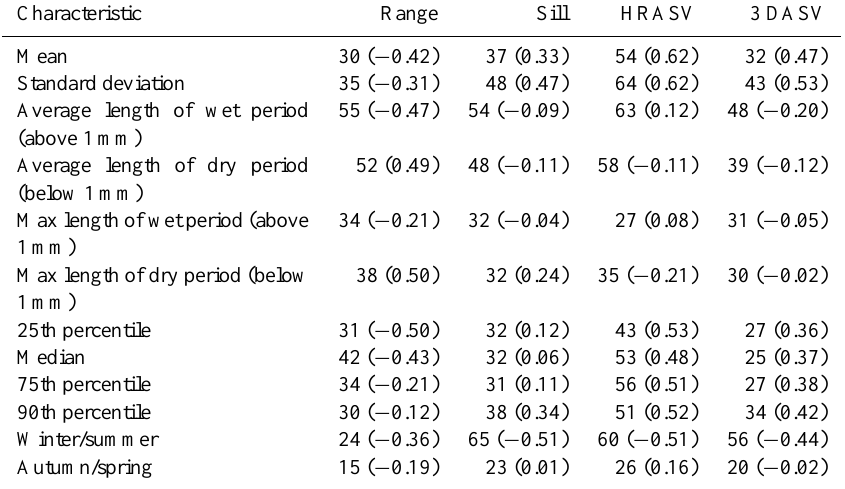
Table 3. Percentage of catchments with significant (at the 95% CL) correlation between the 5-year precipitation and variogram characteris- tics. The average correlation (for catchments with significant correlations) is in